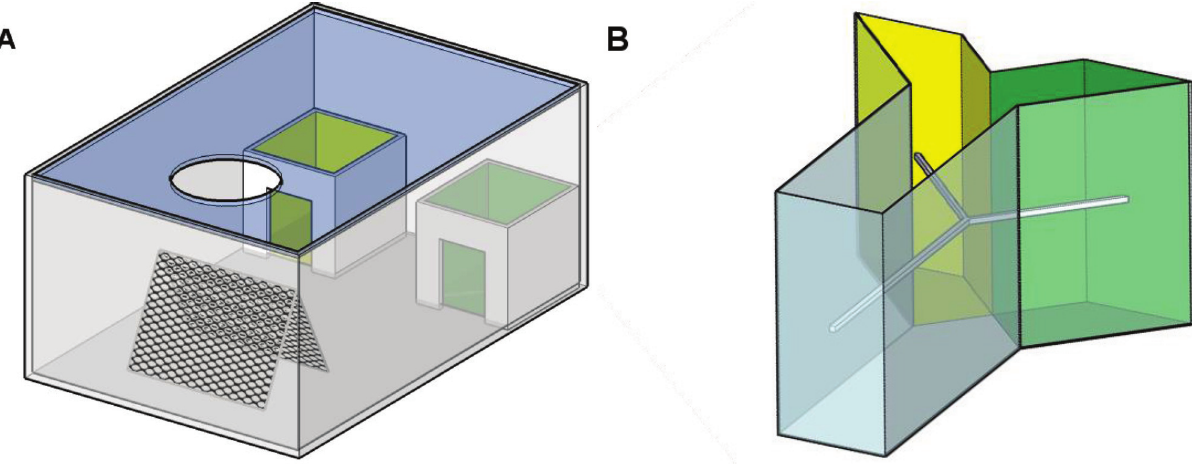
Figure 1. ( a ) The training arena is a rectangular cage with two smaller cages at the far end. The insides of these smaller cages are lined with either yellow or green laminated paper; ( b ) The Y-maze consists of a branch and two smaller side branches, covered with yellow or green laminated paper. Throughout the Y-maze, a wooden rod is suspended on which the animals are allowed to